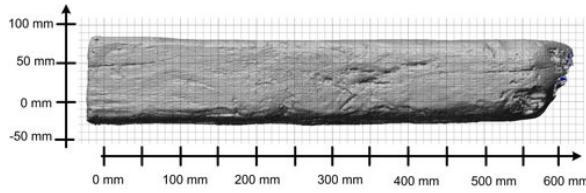
Figure 10. 3D model of a wooden